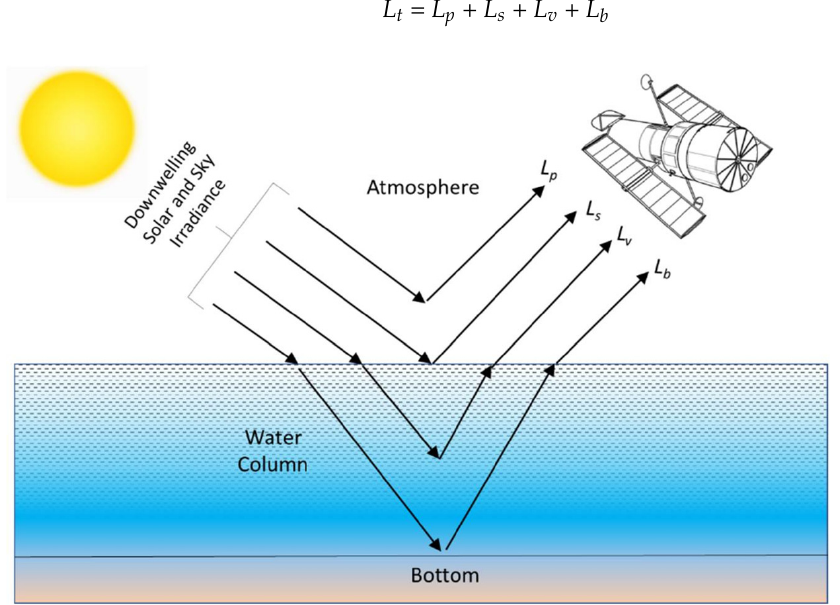
Figure 1. Remote sensing of water quality (modified from